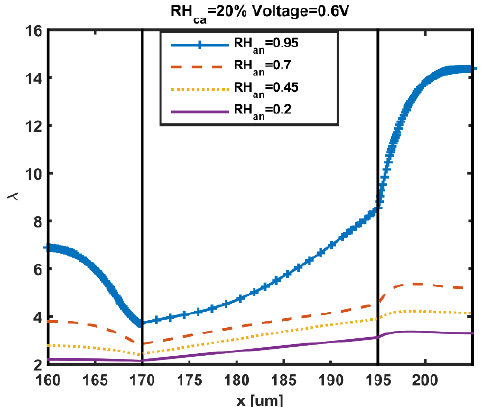
Figure 12. Simulation result of the water content of membrane at different RH an and RH ca = 20%.